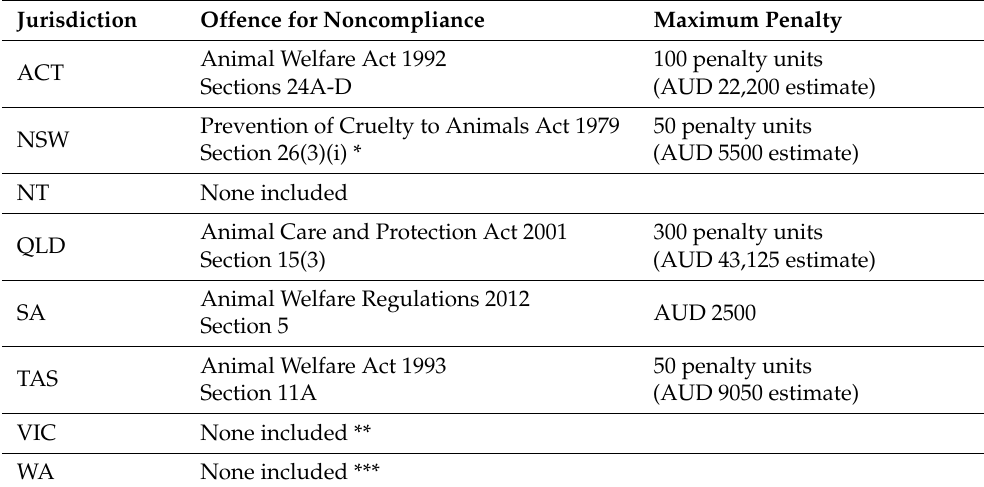
Table 7. Each statutory offence for noncompliance with compulsory codes of practice and the corresponding maximum penalties per each jurisdiction’s animal welfare statute. Penalties are applicable to natural persons. Penalty units refer to a standard unit used to calculate the dollar amount of a fine in line with inflation. Each dollar estimate is based on the penalty units detailed in the crime/sentencing statutes in each jurisdiction as of 6 September 2022. They should be taken as estimates only and will be subject to frequent